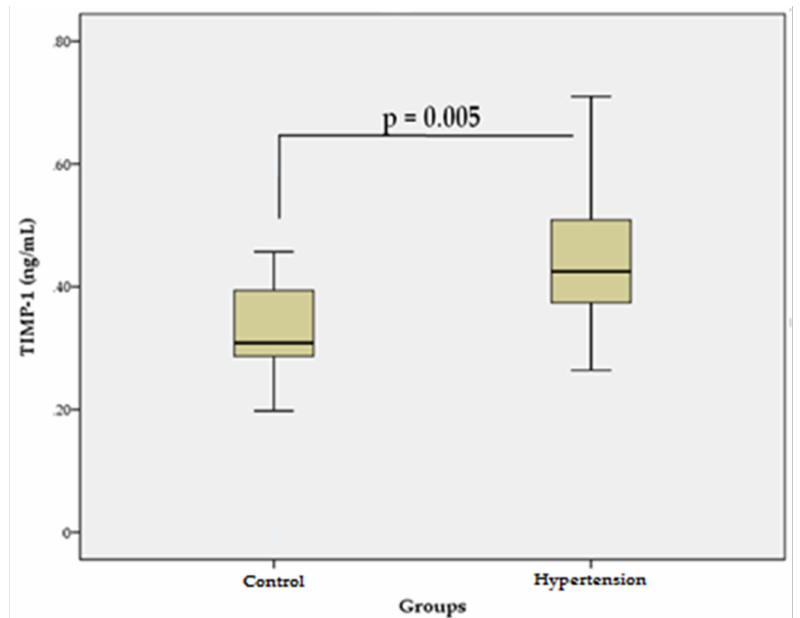
Figure 2. Serum levels of TIMP-1 in the hypertensive group vs. control group. Data are represented as mean ±